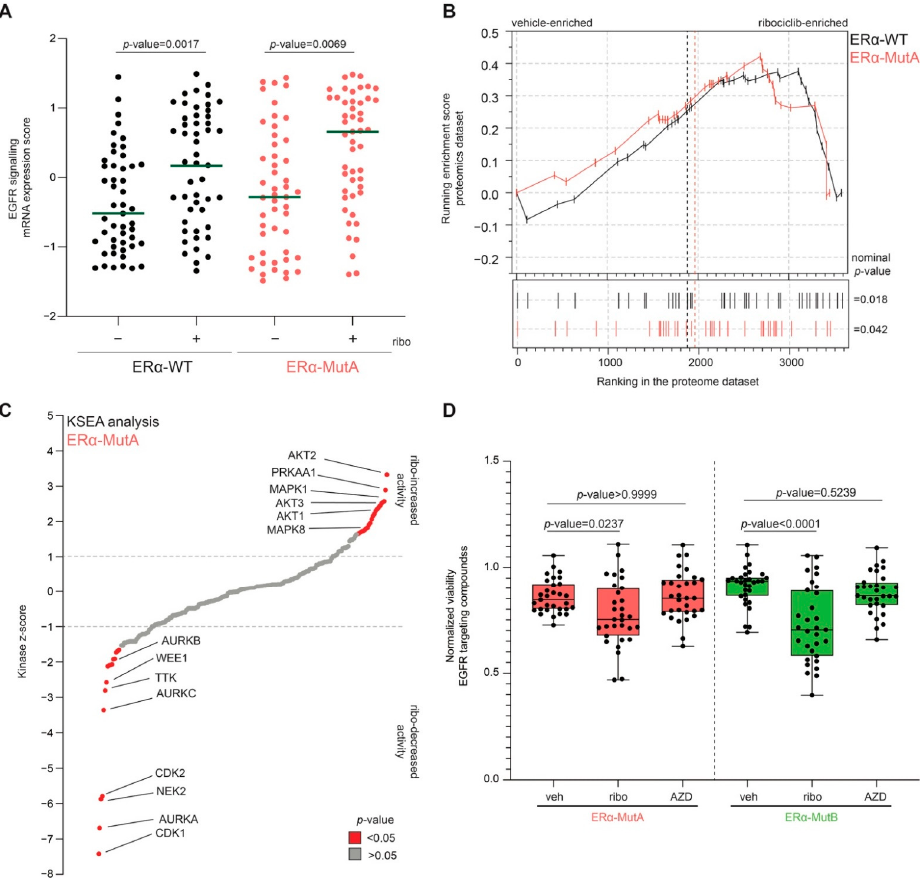
Figure 4. Ribociclib increases the activity of EGFR signalling pathway. ( A ) Scatter plot depicting expression of genes involved in EGFR signalling pathway. Each dot represents a gene, and the green line represents the mean value per condition ( n = 2). p -Values were determined by a two-tailed Wilcoxon matched-pairs signed rank test. ( B ) Gene-set enrichment profiles of whole-proteome data of ER α -MutA and ER α -WT for signalling by receptor tyrosine kinases (M27870) ( n = 4). ( C ) Plot depicting kinases ranked based on the kinase activity z-score calculated using kinase-substrate-enrichment- analysis of phospho-proteomic data ( n = 4). The significant kinases are marked red ( p -value < 0.05, determined by KSEA software). ( D ) Normalized viability of ER α -MutA and ER α -MutB following a five-day treatment with vehicle (veh), ribociclib (ribo), or AZD-9496 (AZD) in combination with 32 different EGFR inhibitors. p -Values were determined using Dunn’s multiple comparison